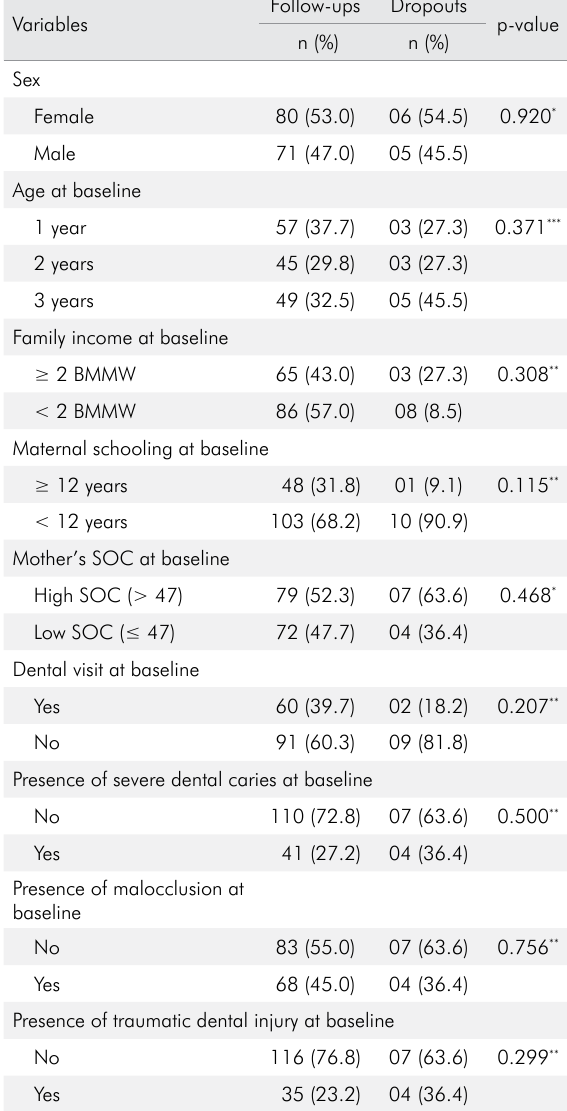
Table 1. Baseline characteristics between follow-up and dropout of participants.